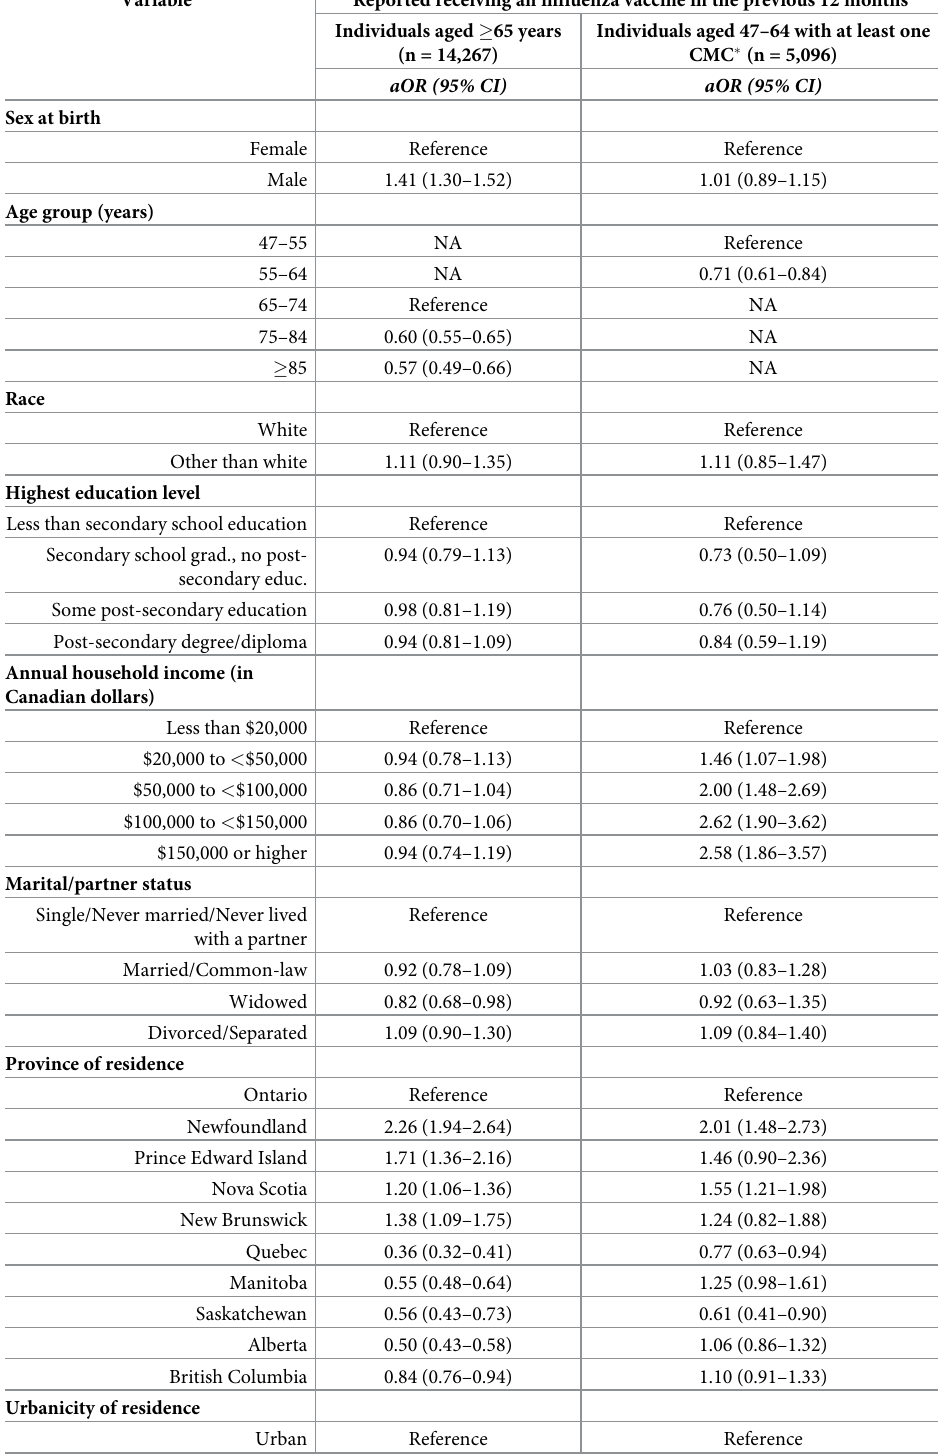
Table 2. Factors associated with missed opportunity for pneumococcal vaccination among CLSA participants aged � 65 years and those aged 47–64 with at least one of select chronic medical conditions (CMC) � who reported receiving an influenza vaccine in the previous 12